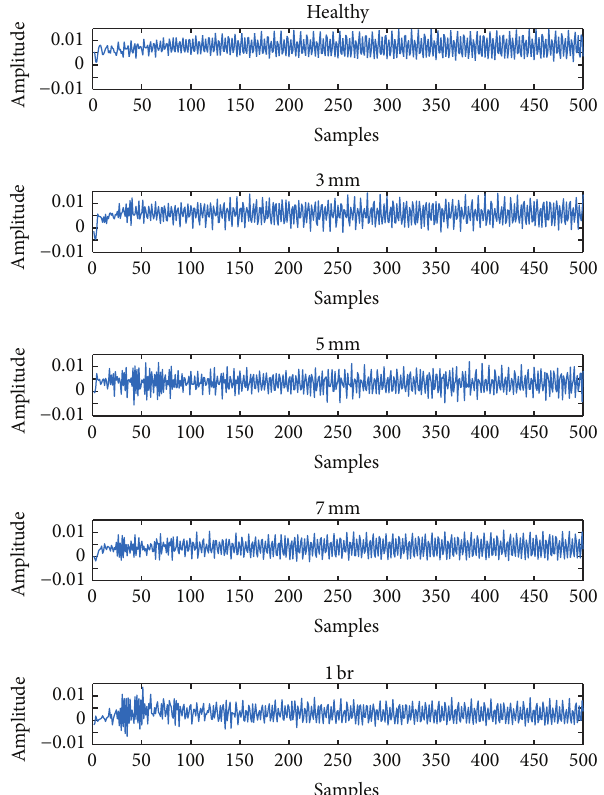
Figure 6: Approximation coefficients at no mechanical load, 𝐴 𝑥 -